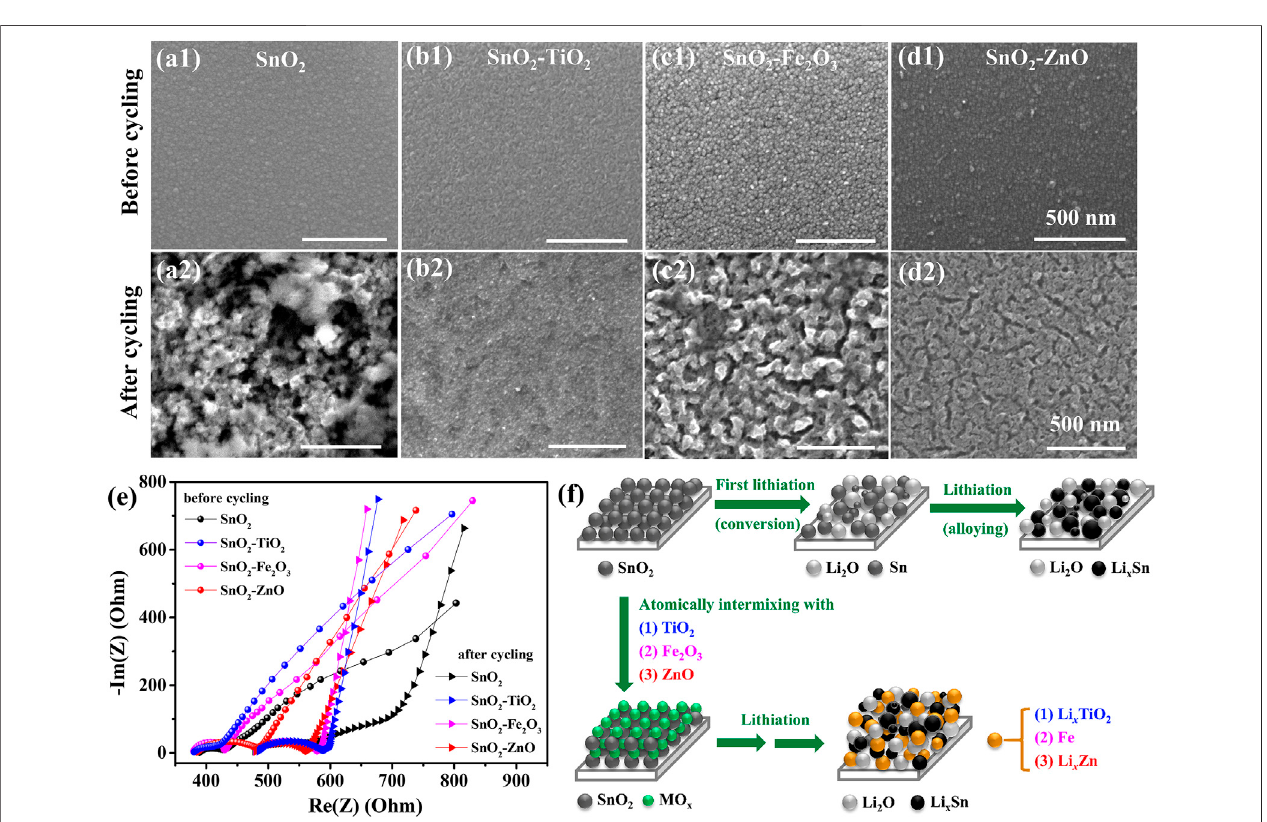
FIGURE 7 | SEM images of the morphology before and after cycling for the (A1,A2) SnO 2 , (B1,B2) SnO 2 – TiO 2 , (C1,C2) SnO 2 – Fe 2 O 3 and (D1,D2) SnO 2 – ZnO electrode. (E) EIS of the electrodes before and after cycling. (F) Schematic illustration of SnO 2 and the effect of atomically intermixing SnO 2 with MO x on the lithiation